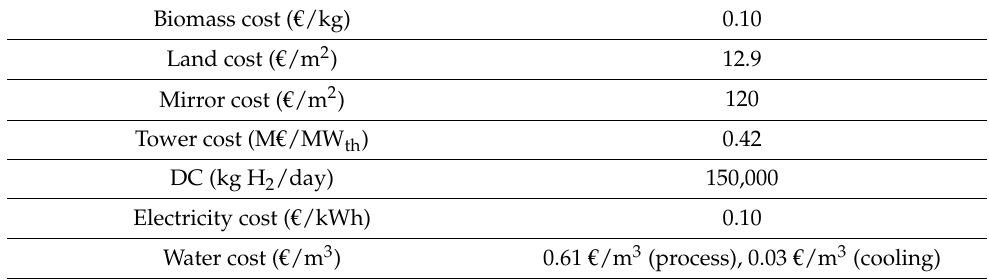
Table 5. Reference assumptions.